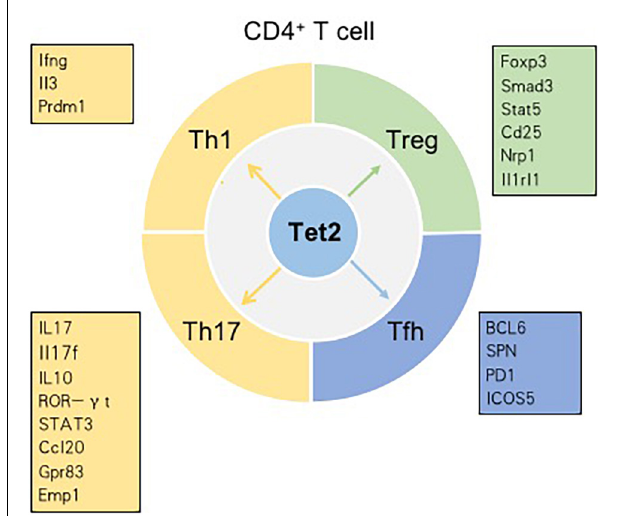
FIGURE 3 | Tet2 modulates the differentiation of CD4 + T cell subsets in a context-dependent manner. Genes in the boxes are involved in the differentiation of CD4 + T cell subsets regulated by